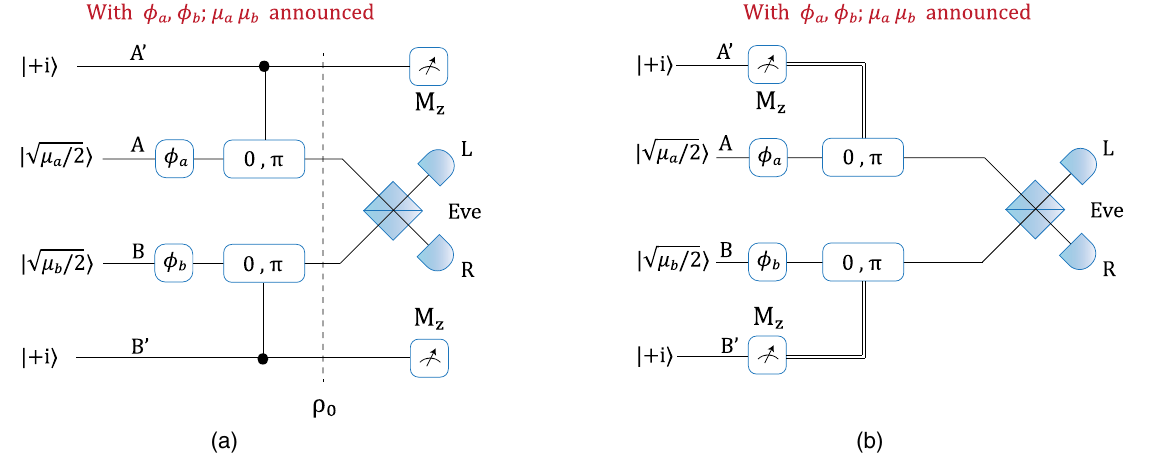
FIG. 7. (a) Schematic diagram of Protocol IV, where the decoy-state method is applied. The random phase ϕ a , ϕ b ∈ ½ 0 ; 2 π Þ . (b) Schematic diagram of PM-QKD